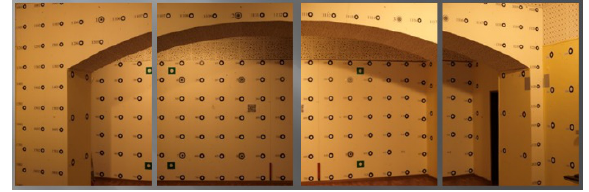
Figure 5. Example of shooting a test-object with a long-focus camera.